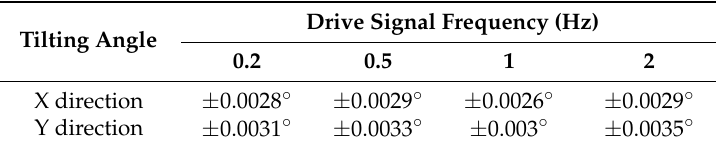
Table 1. Tilt angle variations when the drive signal frequency changes.